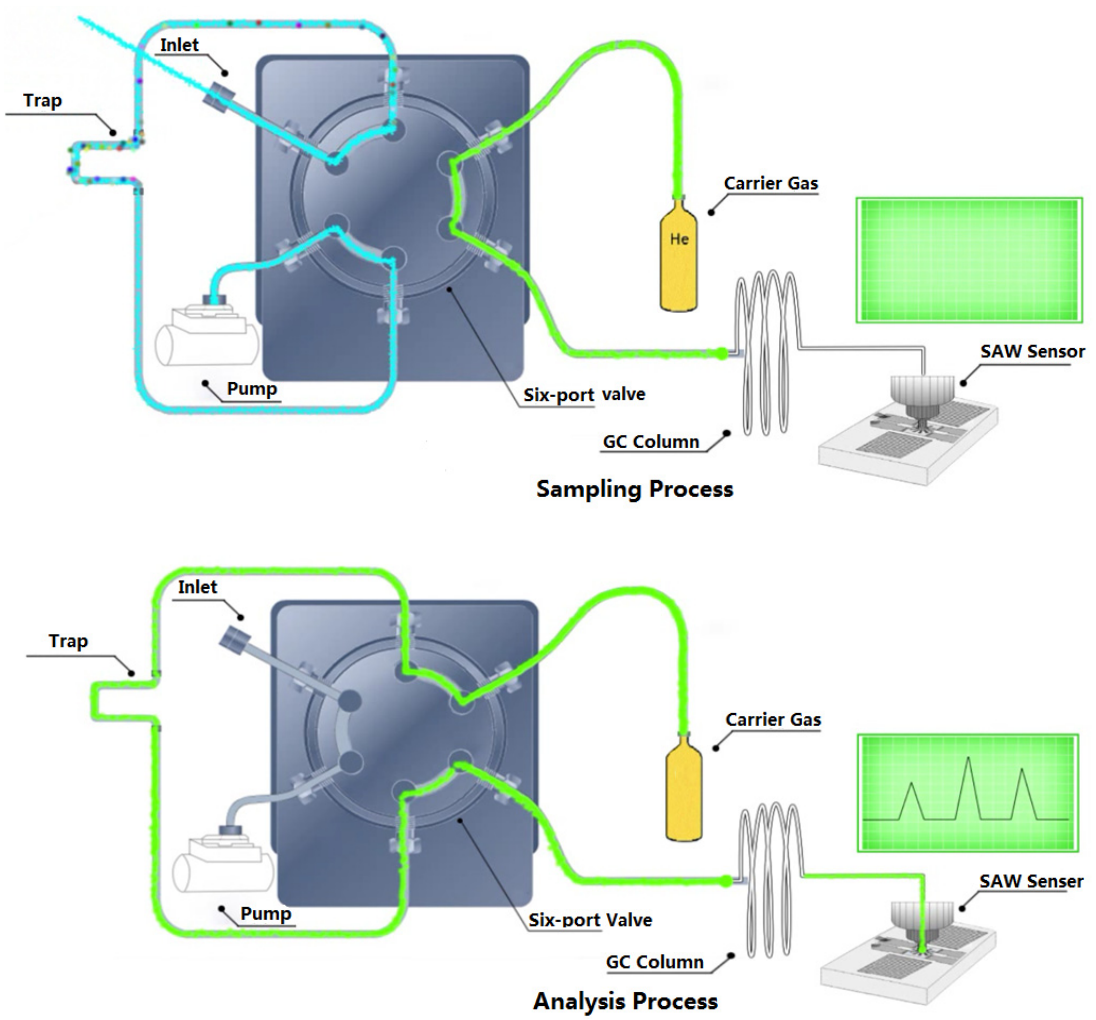
Figure 10. Schematic diagram of GC-SAW. The set-up temperatures were 50 ◦ C for the detector, 200 ◦ C for the injection port, and 160 ◦ C for the valve. The trap was heated rapidly to 200 ◦ C to desorb. The column was heated from 55 ◦ C to 180 ◦ C at a rate of 5 ◦ C/s in 5% phenyl methyl polysiloxane DB-5 (1 m × 0.25 mm). Nitrogen (99.999%) was used as a carrier gas at 4.0 mL/min. Duplicate measurements were carried out per sample. All analytical procedures were completed within 30